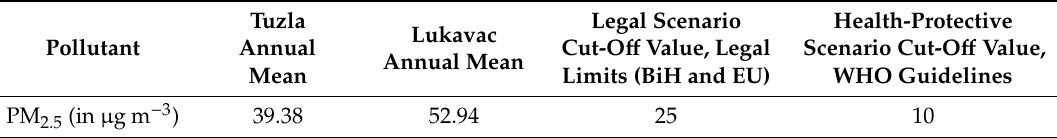
Table 1. Annual mean concentration, cut-o ff value for legal scenario and health-protective